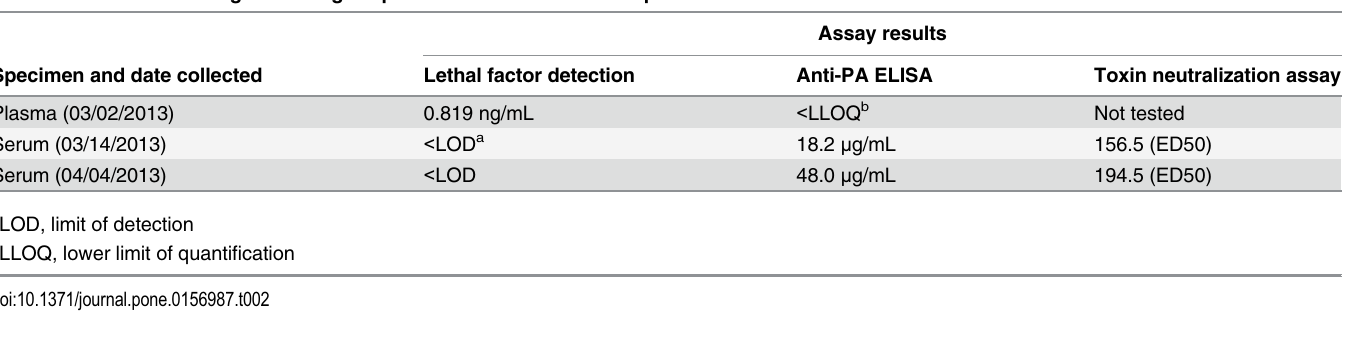
Table 2. Results of serological testing of specimens from 2013 Florida patient with anthrax-like cutaneous